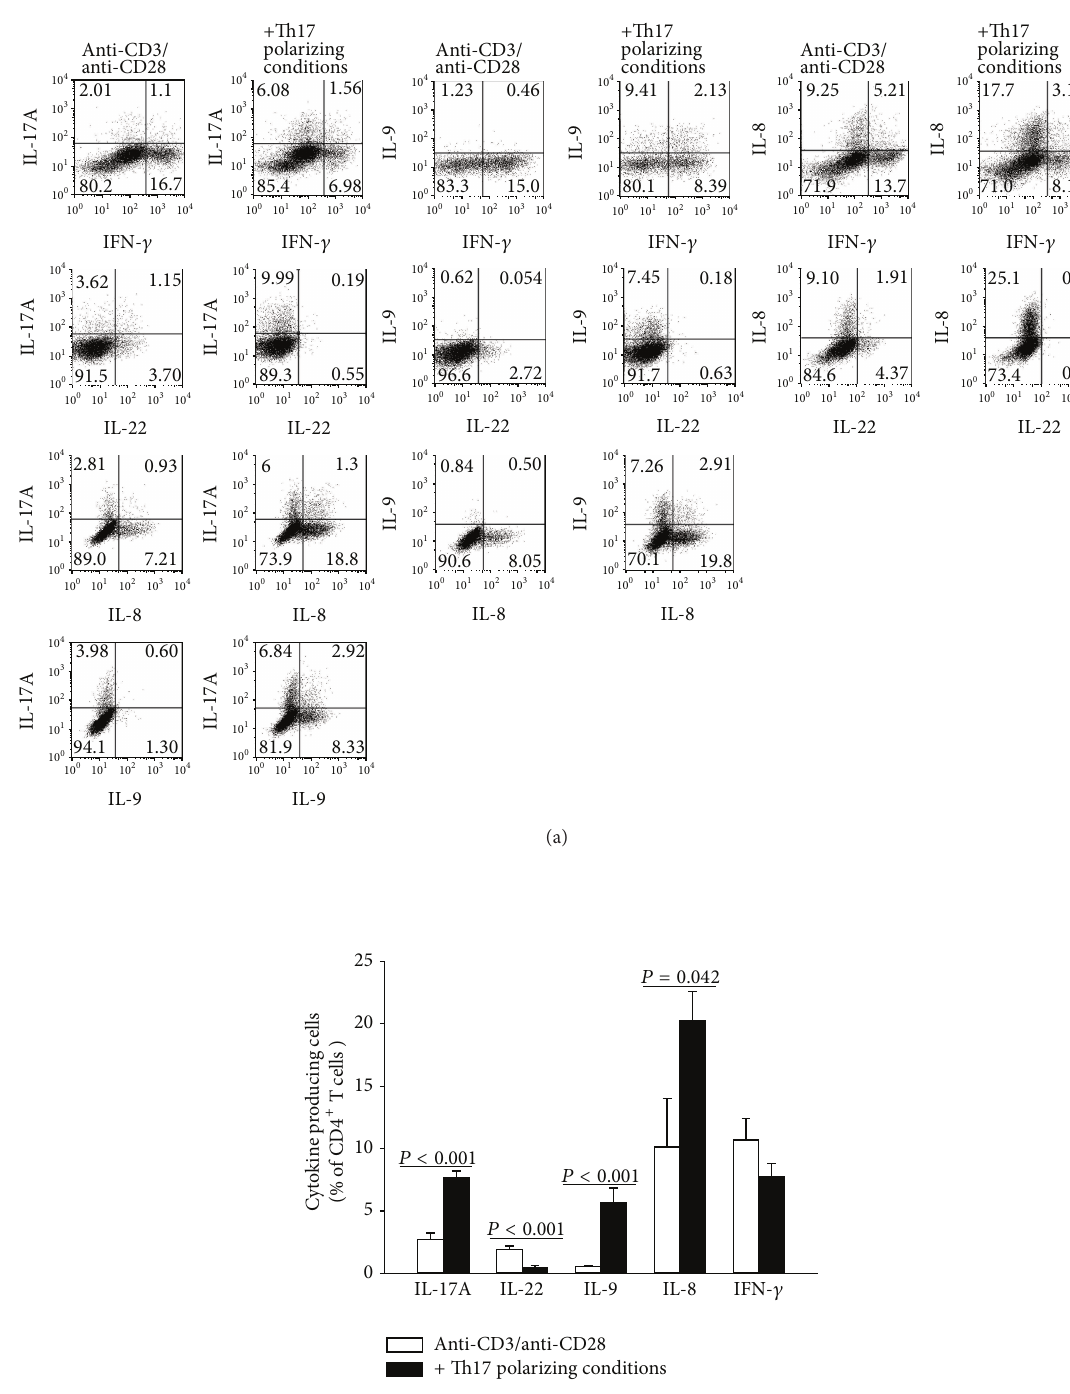
Figure 1: Effect of Th17 polarizing conditions on the T helper cell cytokine production. Human CD4 + T cells were cultured with anti- CD3/anti-CD28 in the presence or absence of Th17 polarizing conditions for five days. After restimulation with PMA, Ionomycin, and Monensin for five hours and fixation/permeabilization the cells were stained for IL-17A, IL-22, IL-9, IL-8, and IFN- 𝛾 and analyzed by flow cytometry. (a) The numbers in the dotplots represent positive cells in %. Data are representative of 3–5 independent experiments. (b) The amount of cytokine producing cells [%] is represented as mean and SEM. Bars with 𝑃 values indicate significant differences between the two groups, Mann-Whitney 𝑈 test, 𝑛 = 5